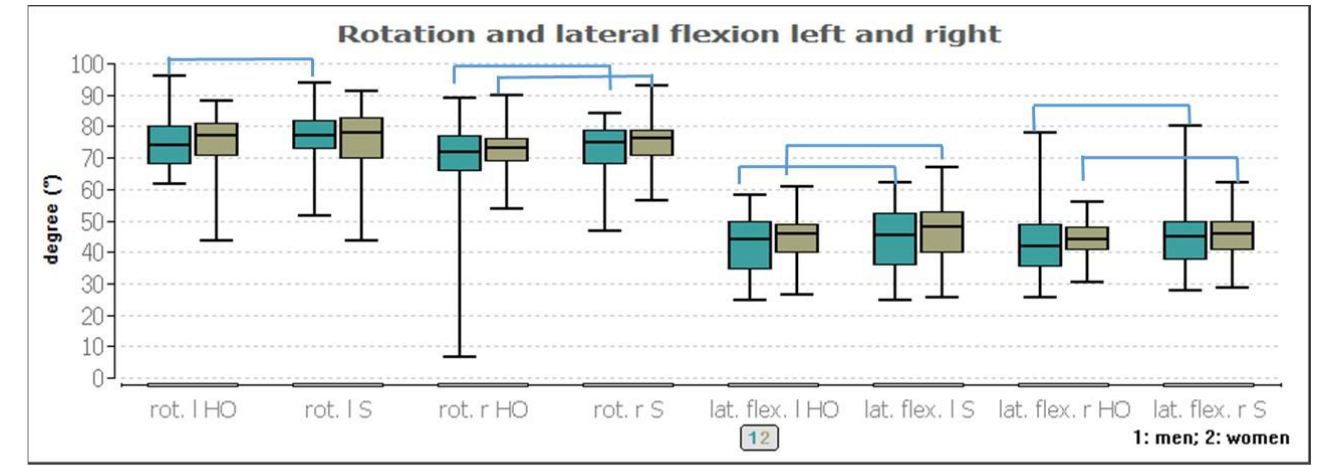
Figure 4. Rotation and lateral flexion to the left and right body side with either habitual occlusion or splint, separated into male and female subjects.